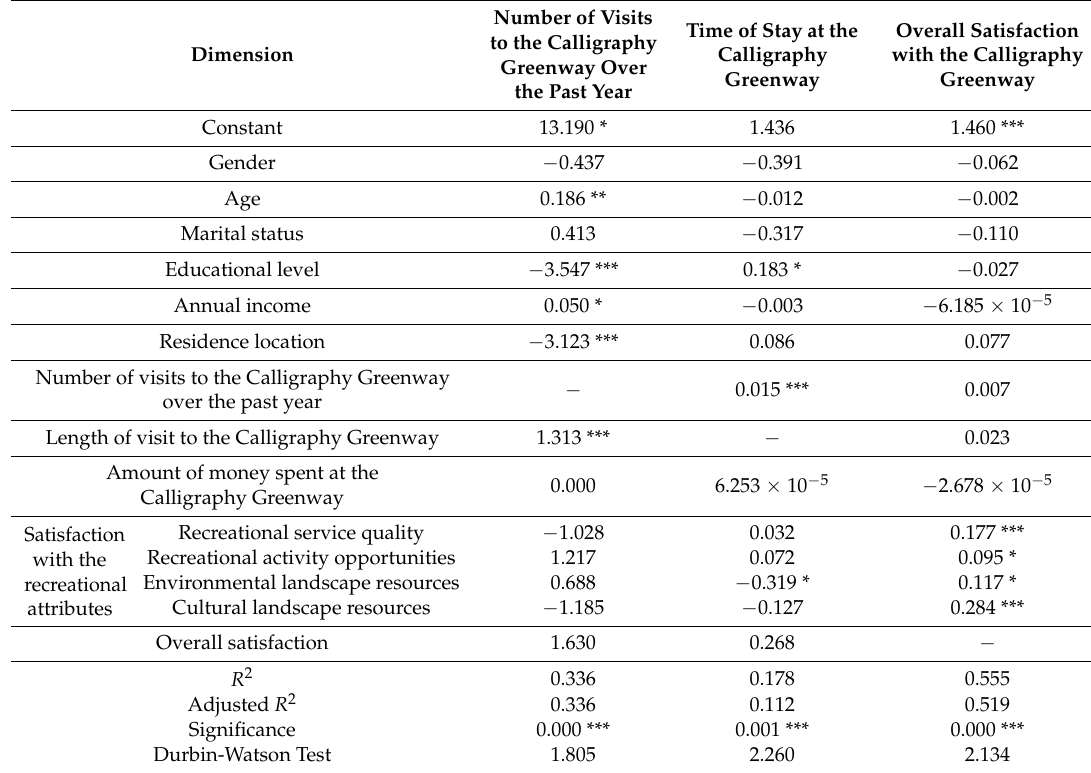
Table 9. Multilinear regression analysis of the data. Number of Visits to the Dimension